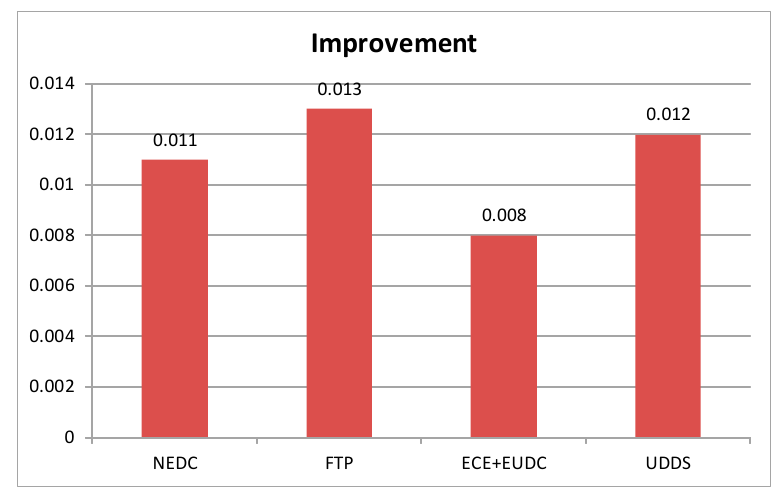
Figure 10. The histogram of the improvement in overall effectiveness between the results using initial and optimal values of the parameters of the control strategy.